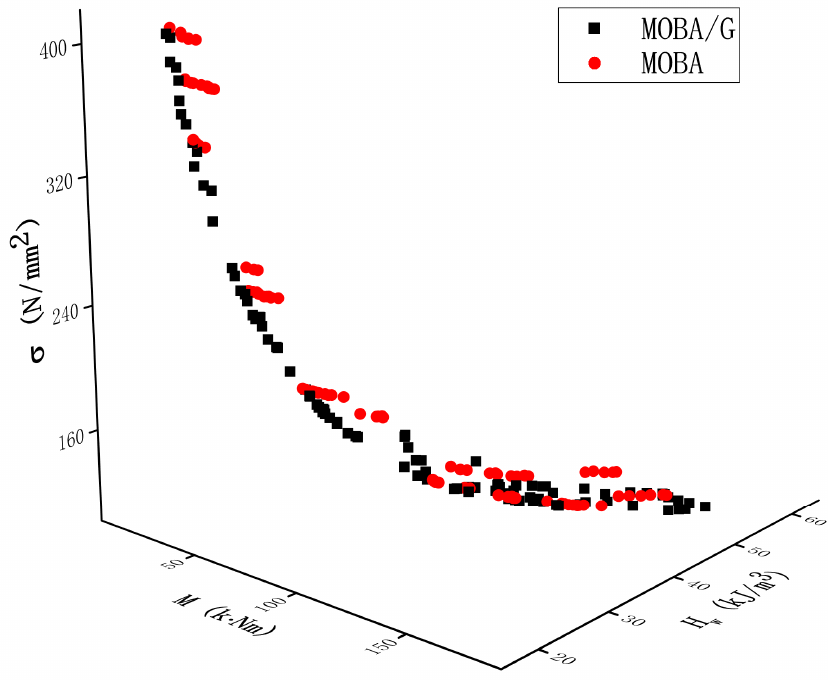
Figure 6. Pareto fronts of MOBA/G and MOBA.